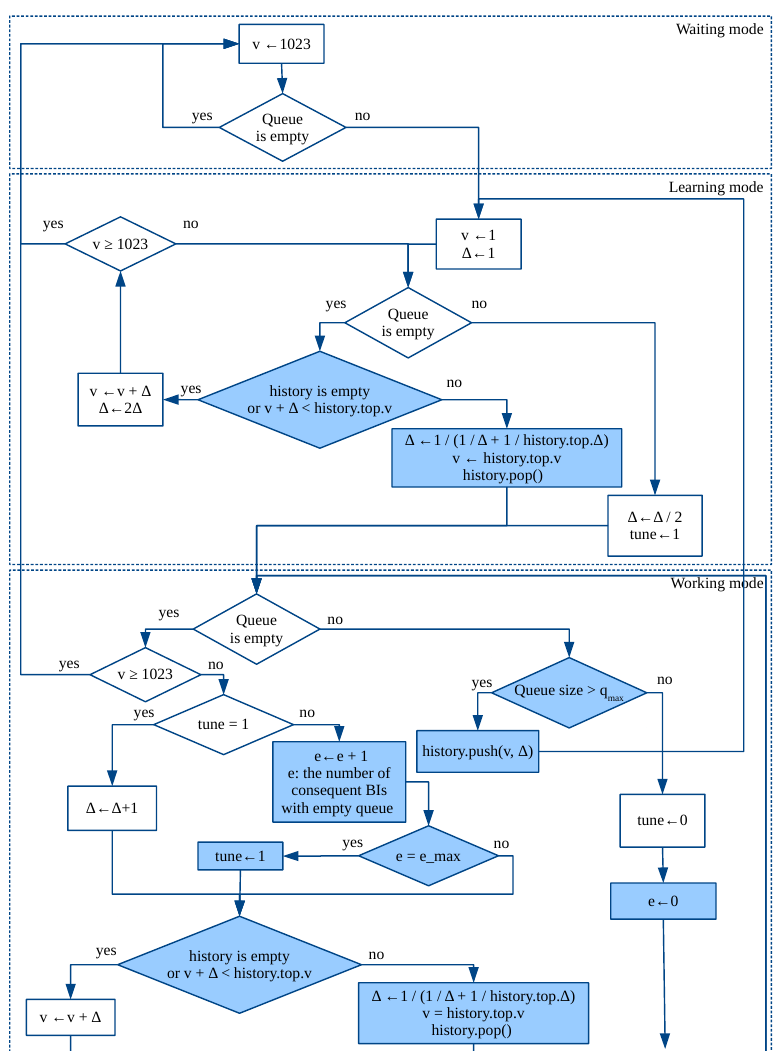
Figure 3. Algorithm for CAC, changes to algorithm ‘Up’ from [6] are shown with painted